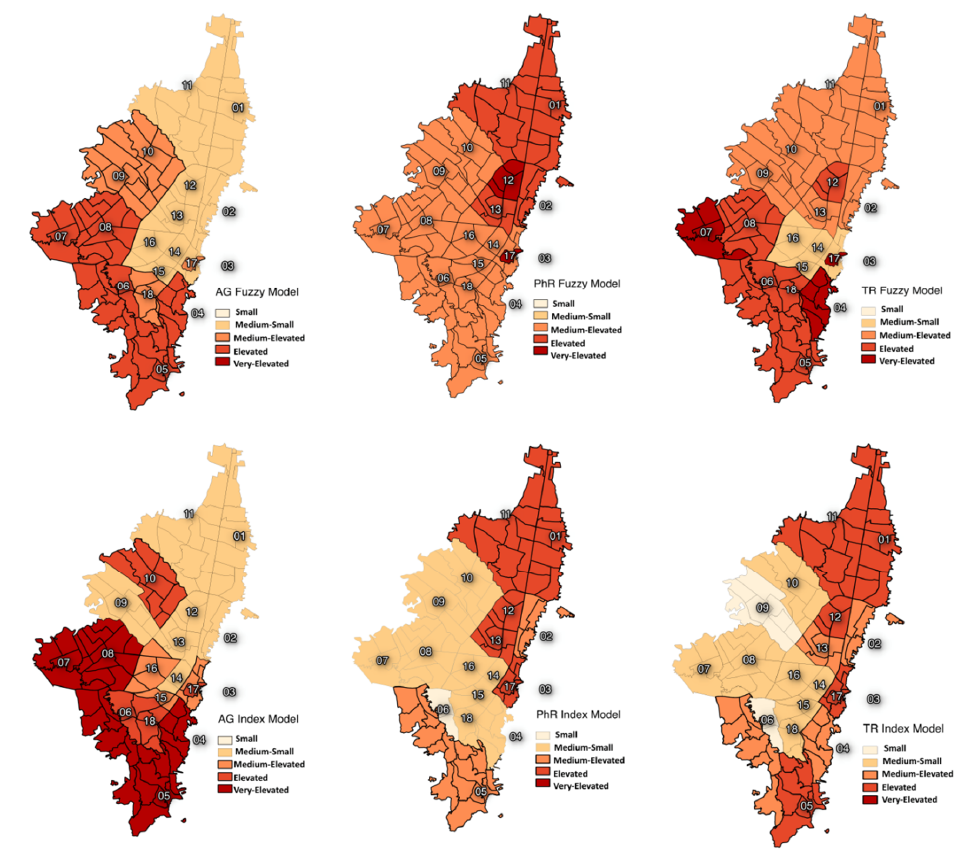
Figure 8. Risk components obtained for Bogota city by: the fuzzy model (upper part) and the index model (lower part). From left to right: social aggravation, physical risk, and total seismic risk. Significant values of each component have been highlighted to show a measure of how the assumption of compensability can lead towards different risk spatial patterns.